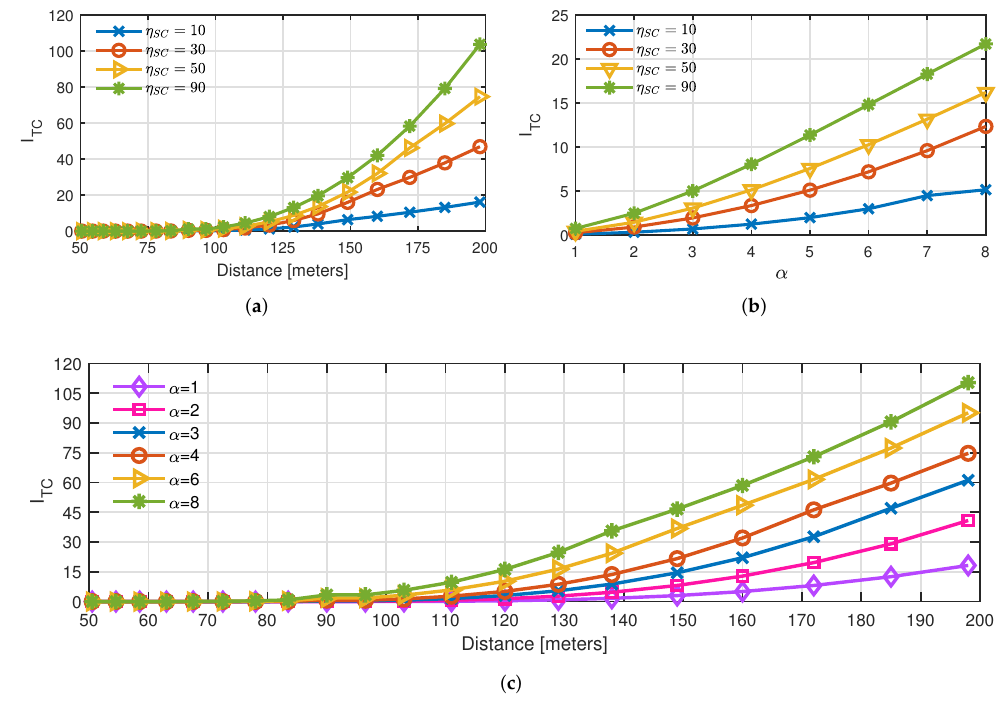
Figure 5. Sum-rate improvement of TC users for various D , α , and η SC . ( a ) For α = 4 ( b ) For D = 120 m ( c ) For η SC =